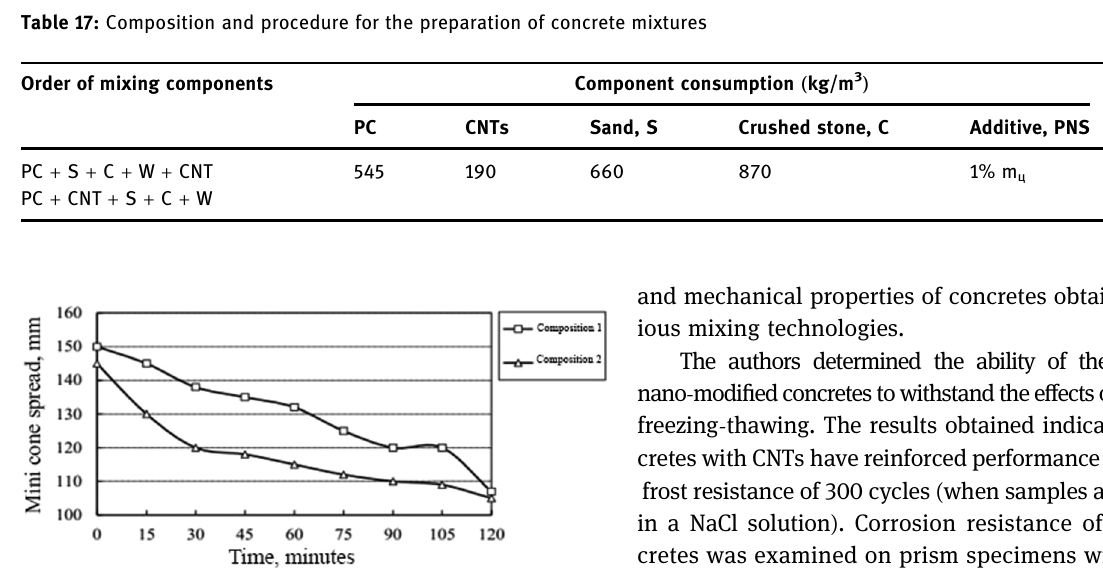
Figure 15: Change in the fl owability of concrete mixtures depending on the preparation technology over